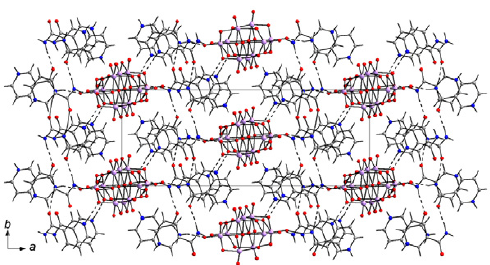
b -axis (dashed lines represent the O-H..O and N-H…O hy- drogen bonds)